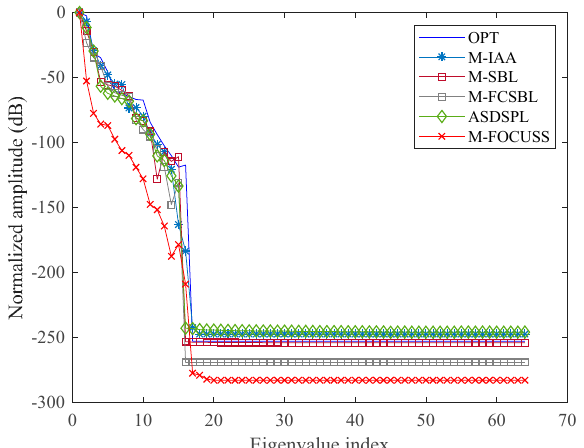
Figure 4. Eigen-spectra of the optimum CNCM and the estimated CNCM in ideal case.